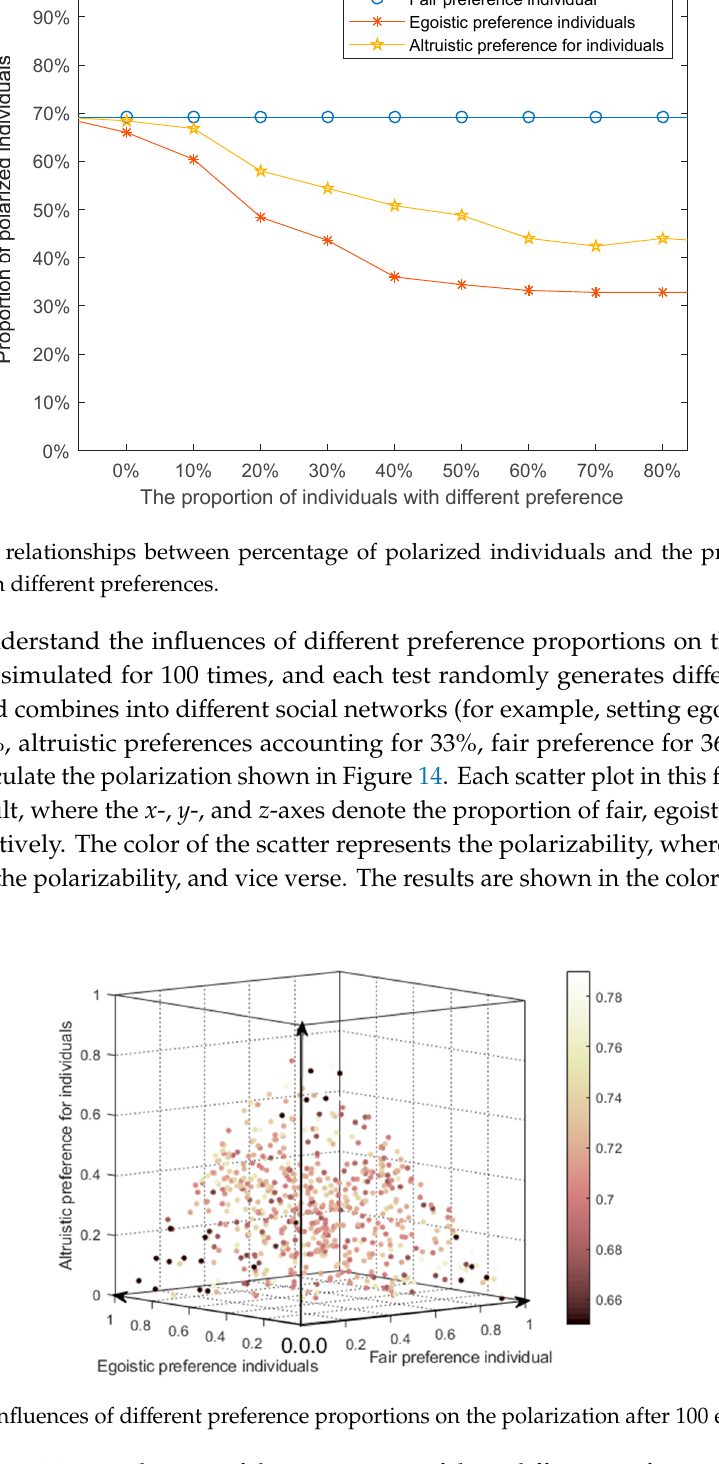
Figure 14. The influences of different preference proportions on the polarization after 100 experiments.